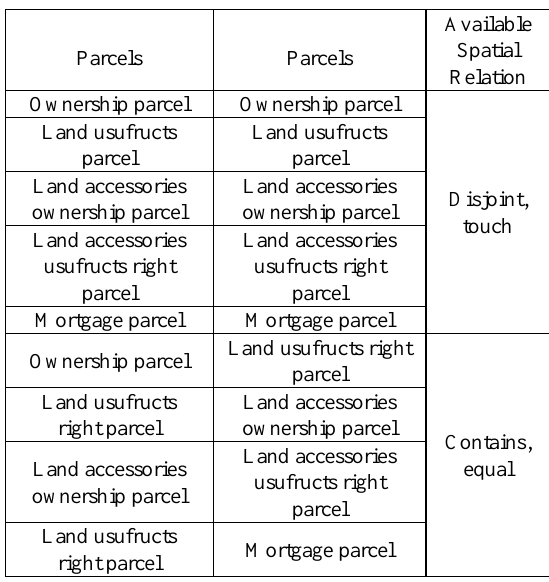
Table 1. Spatial relationship between